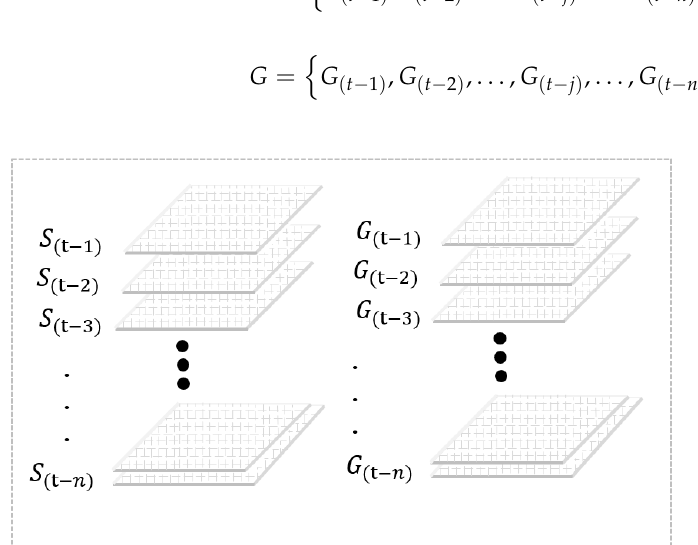
Figure 3. Diagram of the temporal window.